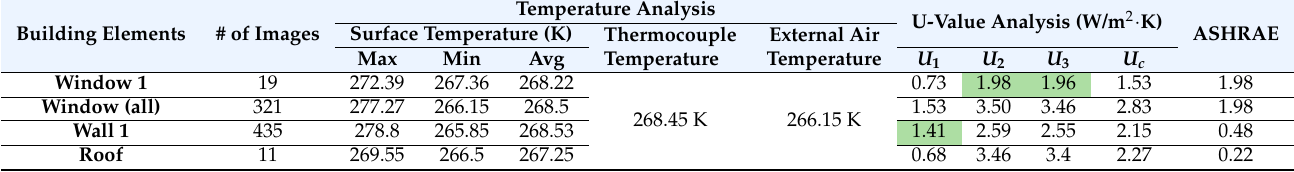
Table 9. Museum U-value estimation (morning) on 17 March 2020.